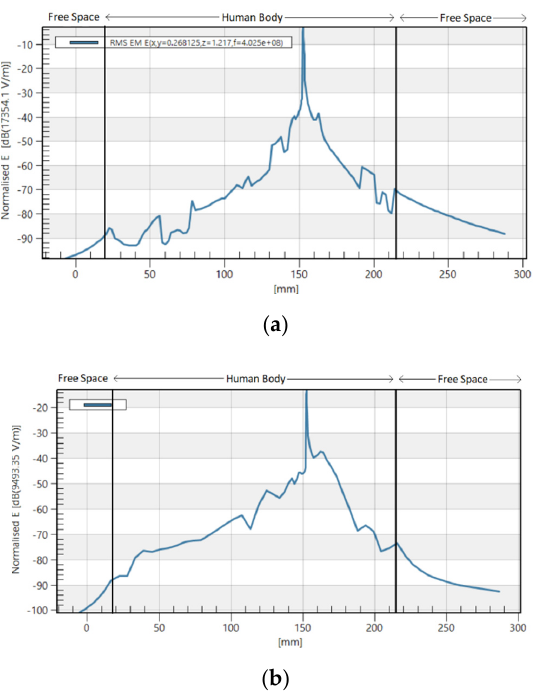
Figure 25. Attenuation of electric field along the x-cut of the male human phantom at ( a ) 402.5 MHz and ( b ) 2.45 GHz.